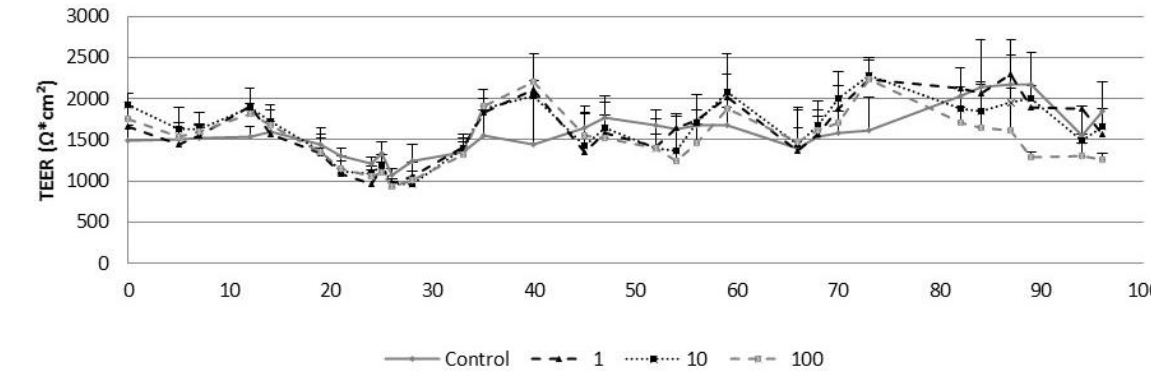
Figure 9. TEER values obtained in the control airway epithelia and in the airway epithelia exposed for three months to different concentrations of CeO 2 -NPs (1, 10, and 100 µg/cm 2 ). Exposures were performed every two weeks for three months. Results are expressed as means ± SD of five replicates per tested condition and one assay ( n = 5).